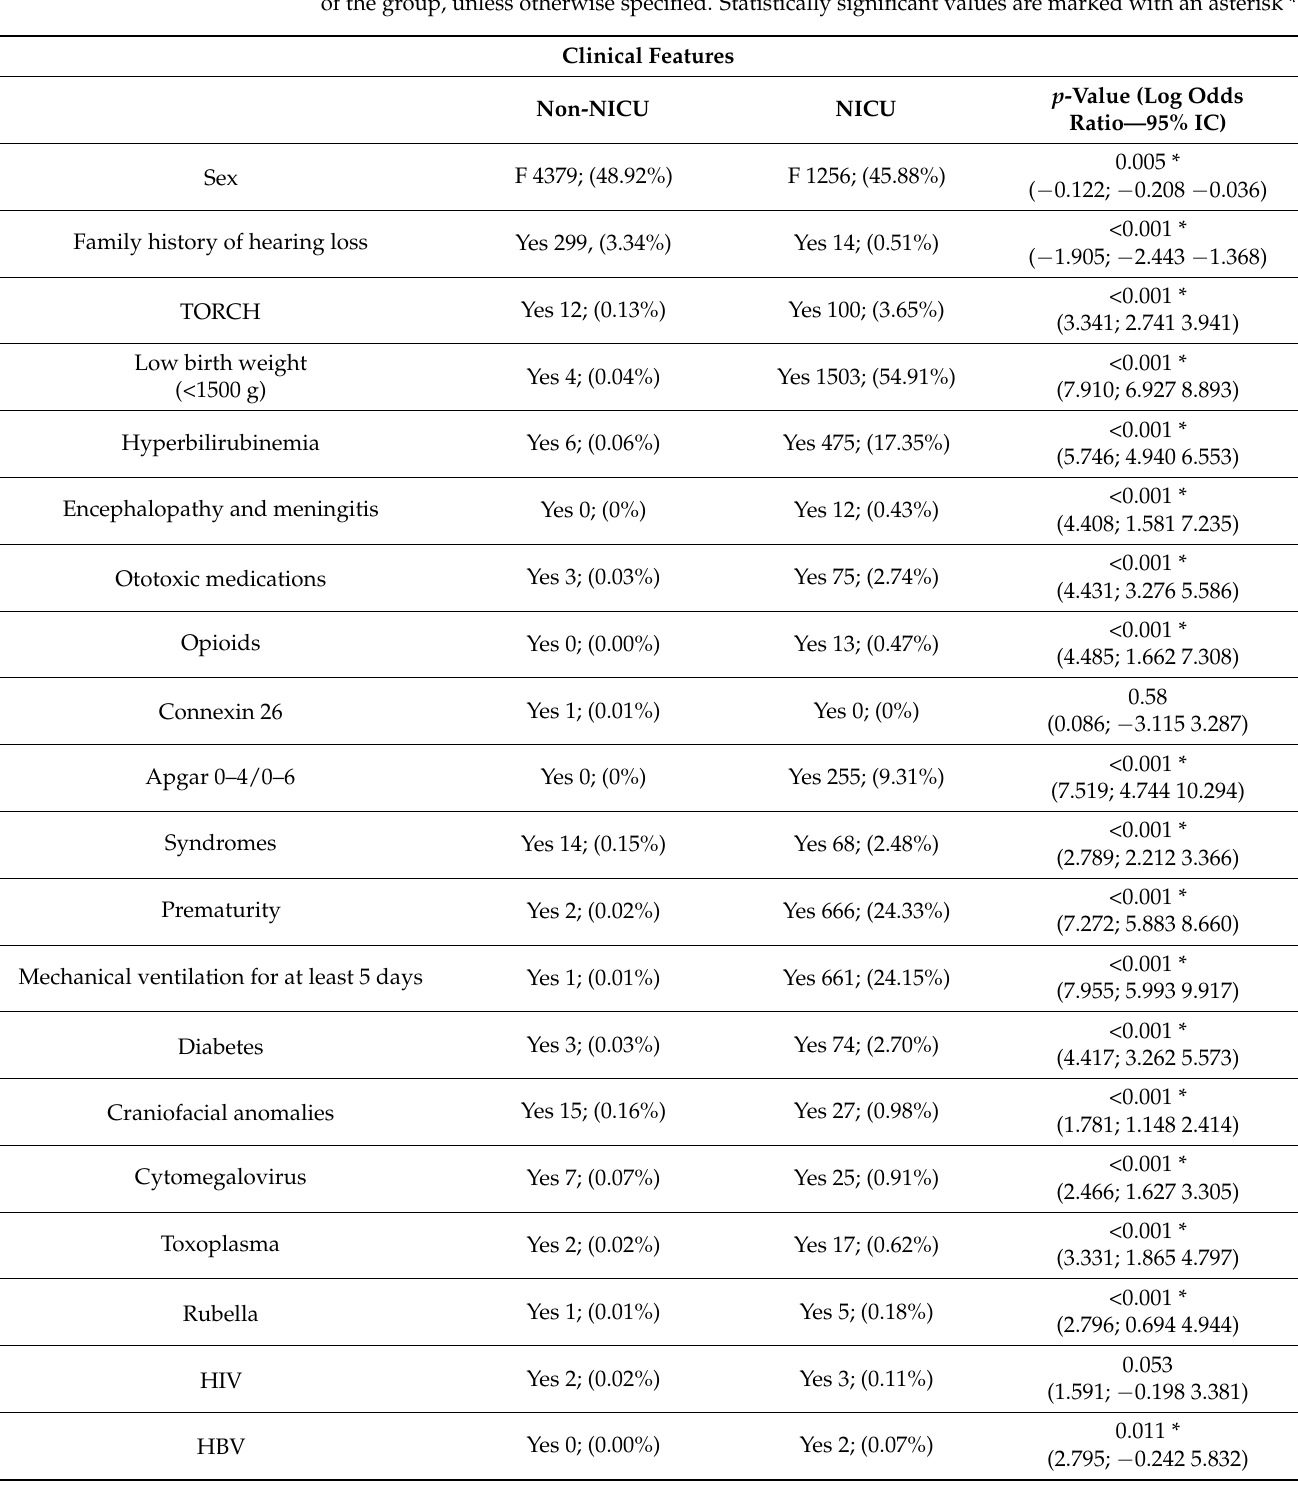
Table 2. Descriptive statistics and comparison of clinical and audiological characteristics of NICU ( n = 2737) and non-NICU ( n = 8951) babies. The degree of hearing loss is defined as follows: 0–4/0–6 refers to the apgar score at 1 and 5 (cid:48) . Serological positive tests were performed on mothers, and seldom confirmed on babies. Ototoxic medications refer to aminoglycosides in multiple courses and/or in association with loop diuretics. Percentages are calculated on the total number of newborns of the group, unless otherwise specified. Statistically significant values are marked with an asterisk